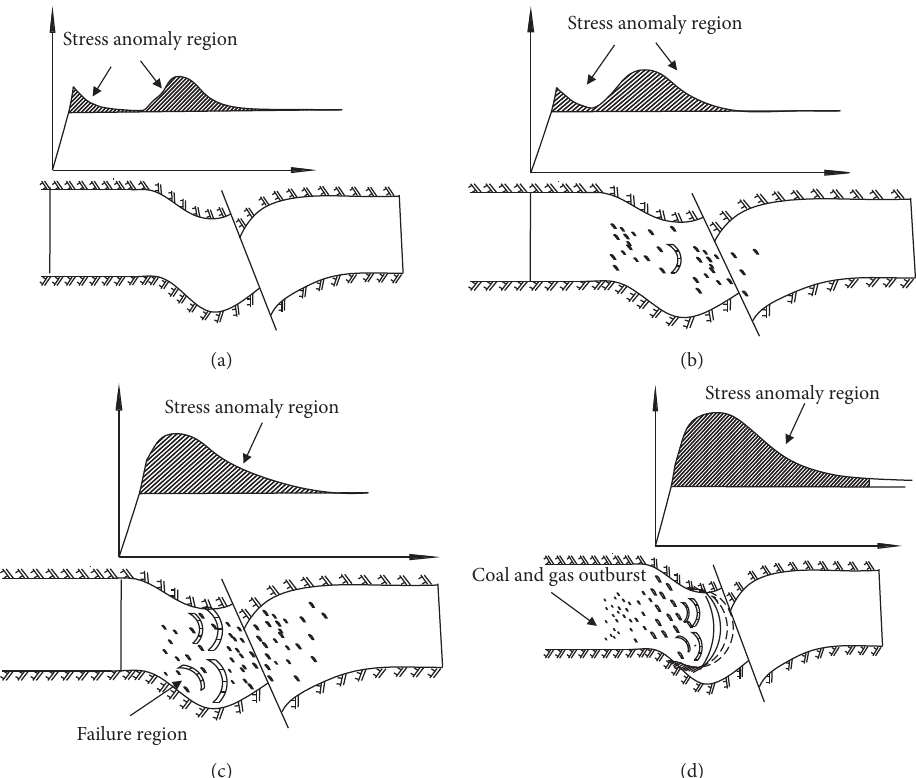
Figure 9: Evolution model of deep low gas dynamic